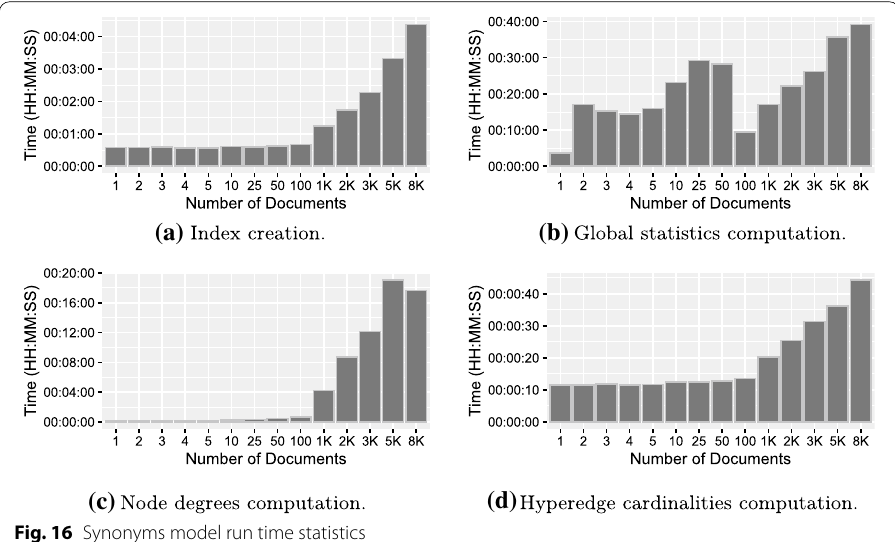
Fig. 16 Synonyms model run time